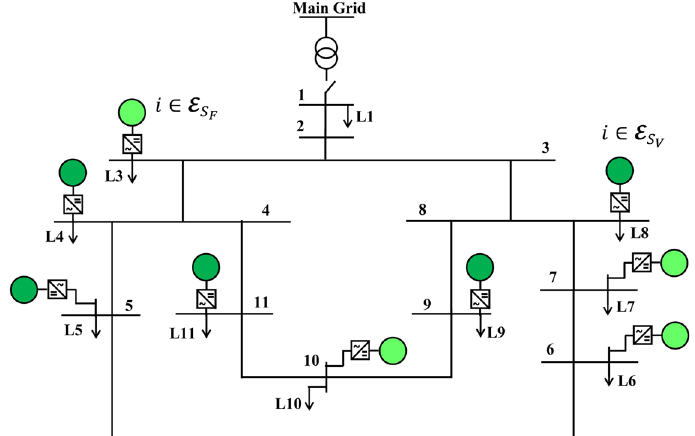
Fig. 10 Test system topology